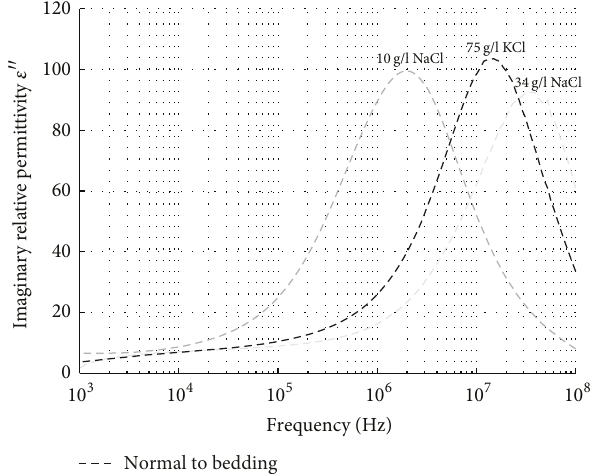
Figure 13: Frequency dependent dielectric loss in brine saturated artificial